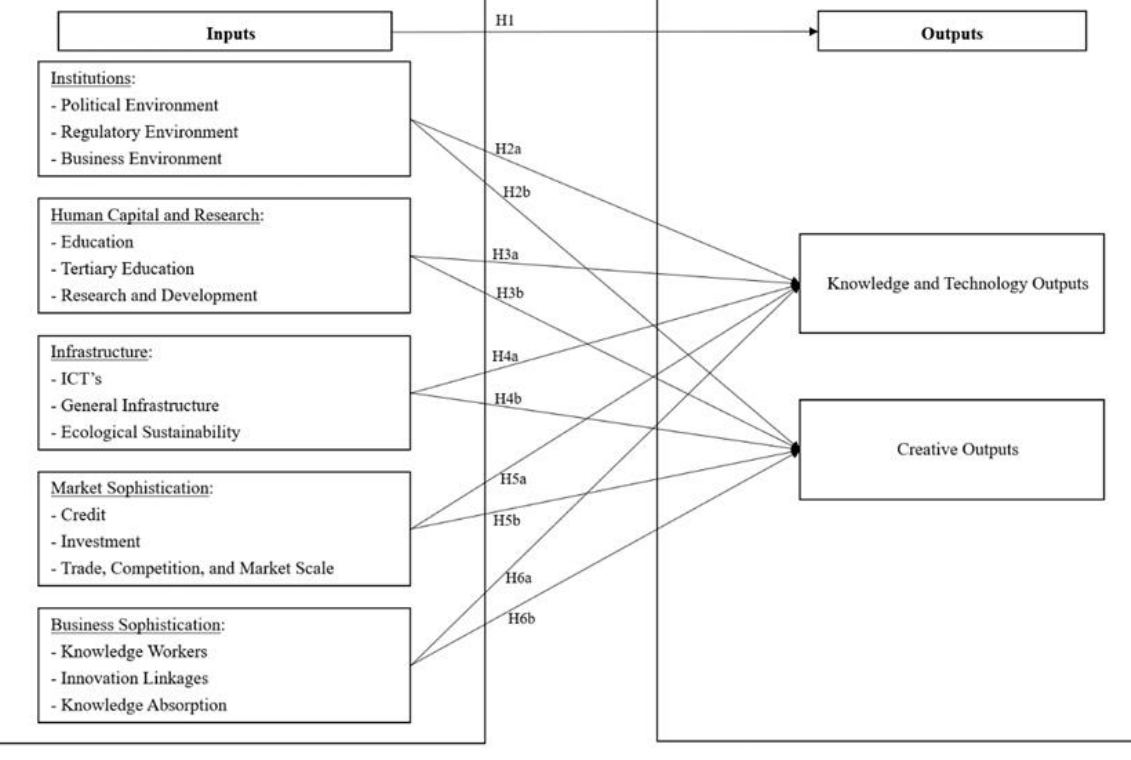
Figure 2. Conceptual model Source: Own